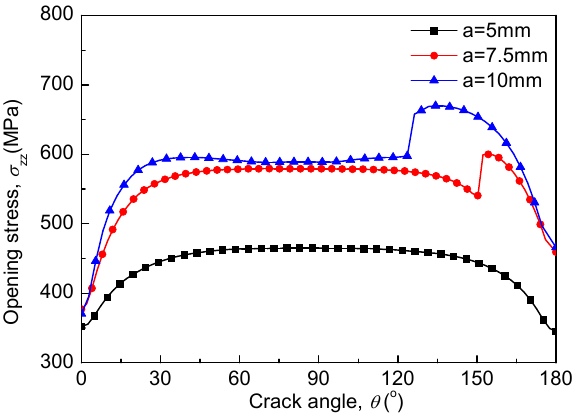
Figure 8: Opening stress ahead of crack fronts ( r 0 =60 μ m). Figure 9: Normal plastic strain ahead of crack fronts ( r 0 =60 μ